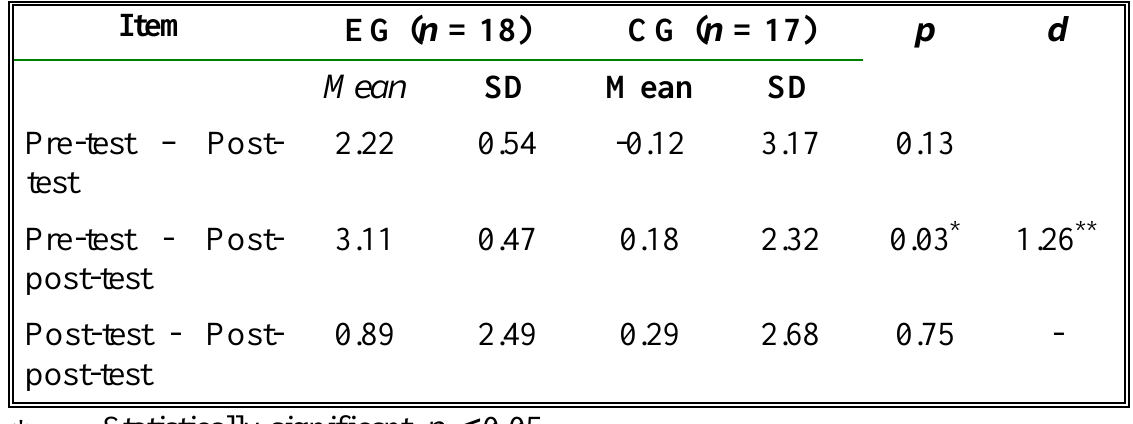
Significance of differences between the experimental and control groups on the